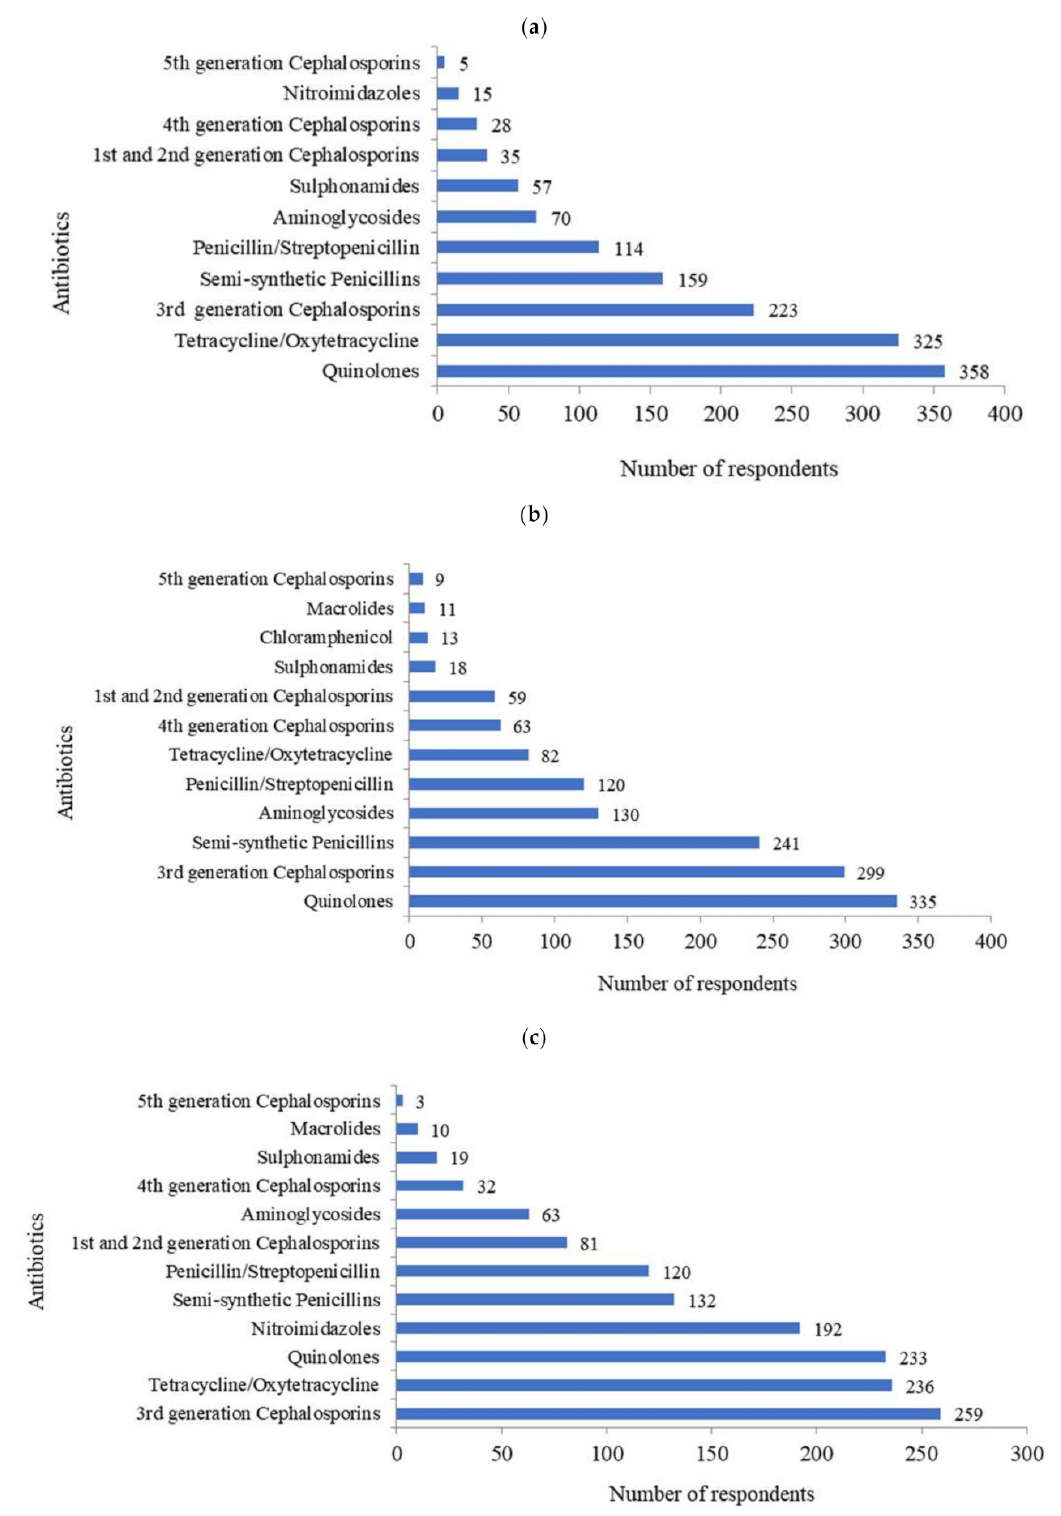
Figure 3. Commonly used antibiotics in bovines (( a ) overall use; ( b ) use in mastitis; ( c ) use in metritis)* (* Questions: ( a ) Top three frequently used antibiotics in the treatment of bovines; ( b ) Top three frequently used antibiotics for the treatment of mastitis in bovines; ( c ) Top three frequently used antibiotics for the treatment of metritis in bovines. Each veterinarian was asked to choose up to three most commonly used